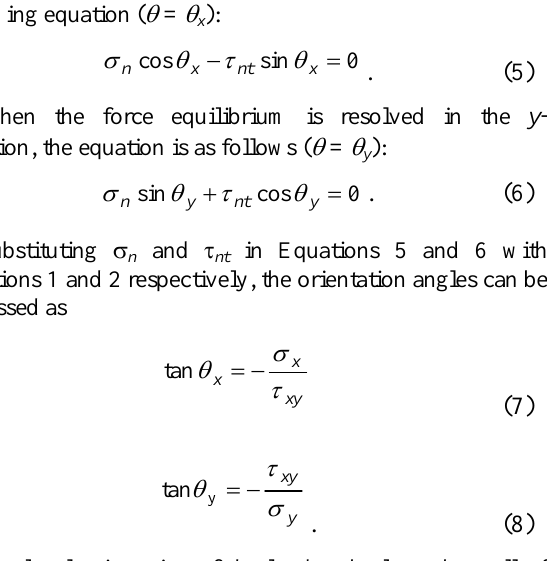
Fig. 4 . Schematic of force “stream tube” that must satisfy The red lines trace the trajectory of path obtained by equilibrium Waldman deri flow articular force n Figure 4, there force across the boundary of the force tube.